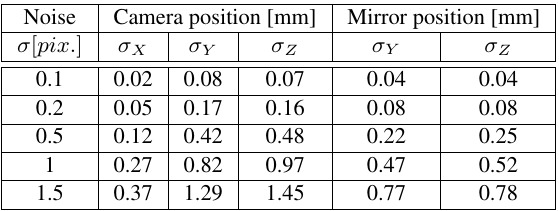
Table 4. Parameter accuracy measures as a function of the noise level, using two circles arrangement (Fig.